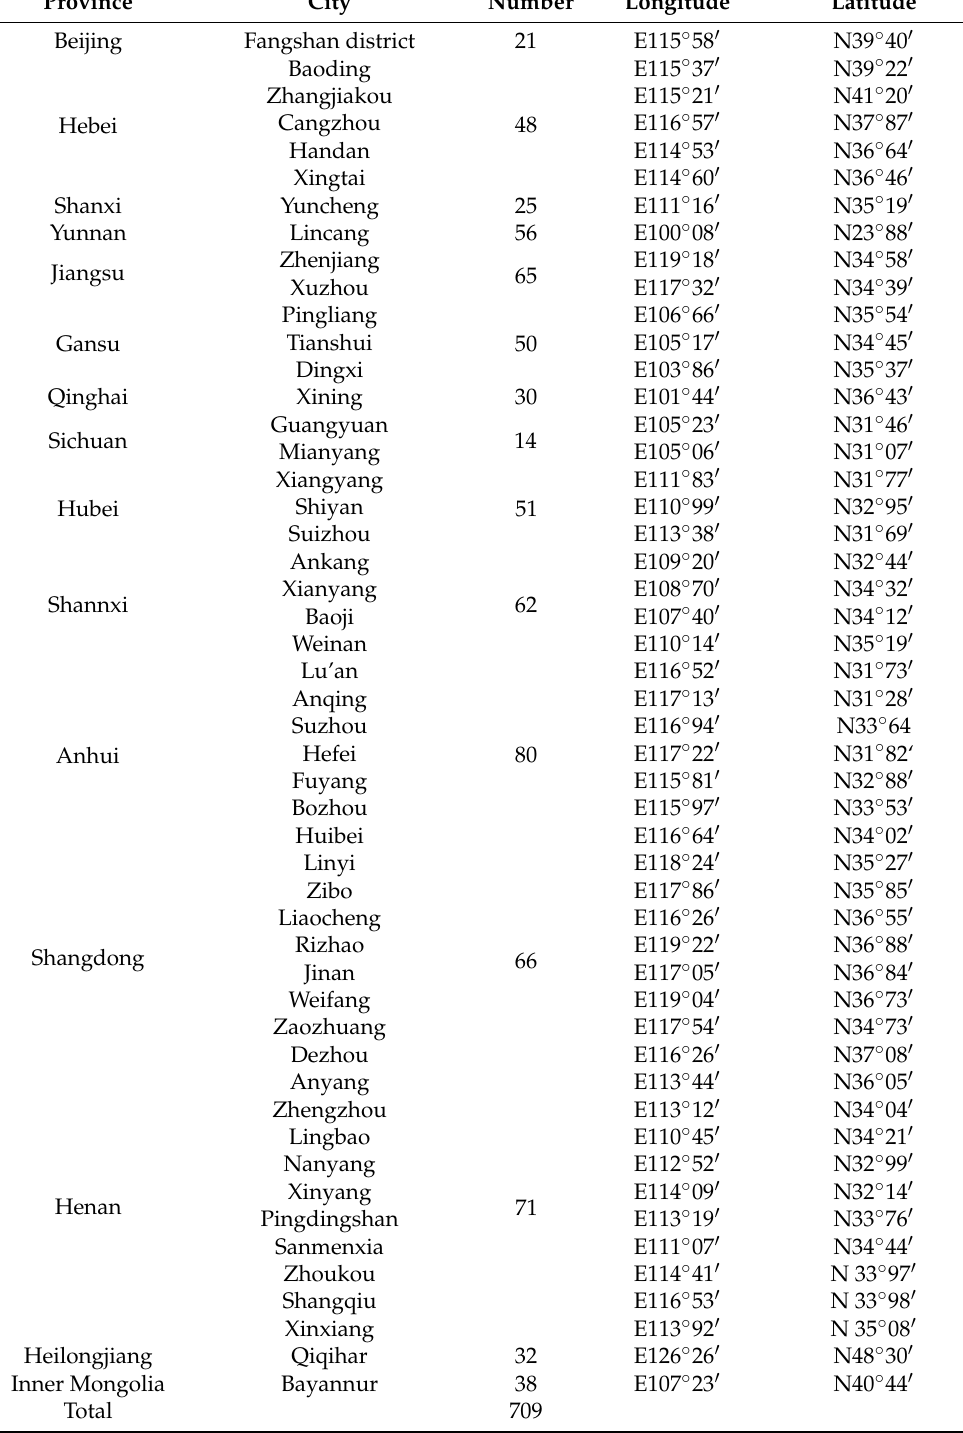
Table A1. Information of the samples of Pt collected from different areas in